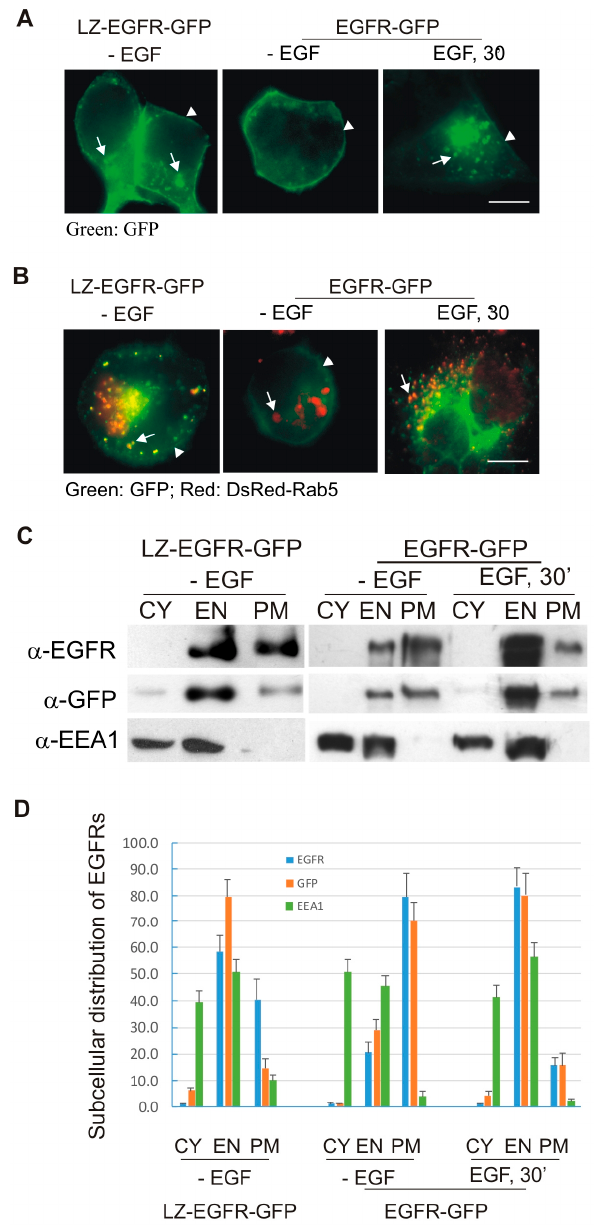
Figure 3. Subcellular distribution of LZ-EGFR-GFP. ( A , B ) Fluorescence analysis of subcellular EGFR localization. 293T cells were transiently transfected with LZ-EGFR-GFP or EGFR-GFP ( A ), or co-transfected with DsRed-Rab5 and LZ-EGFR-GFP or EGFR-GFP ( B ). The cells were treated with or without EGF. The subcellular localization of EGFR and Rab5 was revealed by the intrinsic fluorescence of GFP and DsRed. Co-localization of EGFR and Rab5 was indicated by yellow. Arrows denote endosomes and arrowheads denote plasma membrane regions. Size bar = 20 µm; ( C ) Subcellular fractionation and immunoblotting analysis. 293T cells transiently expressing LZ-EGFR-GFP were homogenized and subcellularly fractionated into cytoplasmic (CY), endosomal (EN) and plasma membrane (PM) fractions, confirmed by immunobloting the cooresponding fraction lysates with antibodies to EGFR, GFP and early endosome antigen 1 (EEA-1), respectively. 293T cells transfected with EGFR-GFP were used as controls; ( D ) Quantification of the data from ( C ). Bands were quantitated by densitometry with image J software and subcellular distribution of the proteins among the three fractions (CY, EN, and PM) was expressed as percentage of the total protein content of all three fractions combined.Each value is the average of at least three independent experiments and the error bar is the standard error.